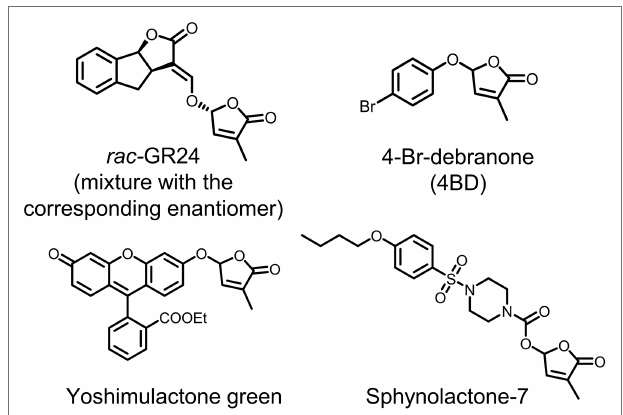
FIGURE 1 | Chemical structures of the synthetic strigolactone (SL)